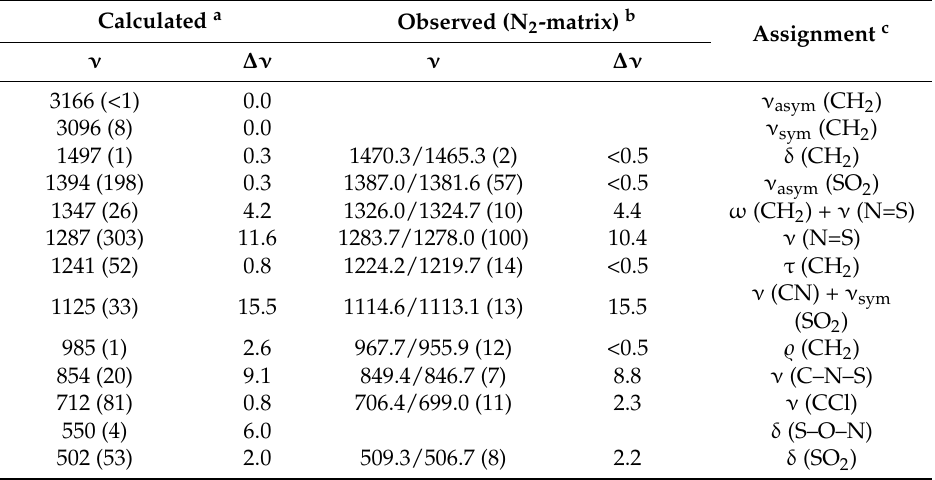
Table 2. Calculated and observed IR frequencies (>500 cm –1 ) of CH 2 ClNSO 2